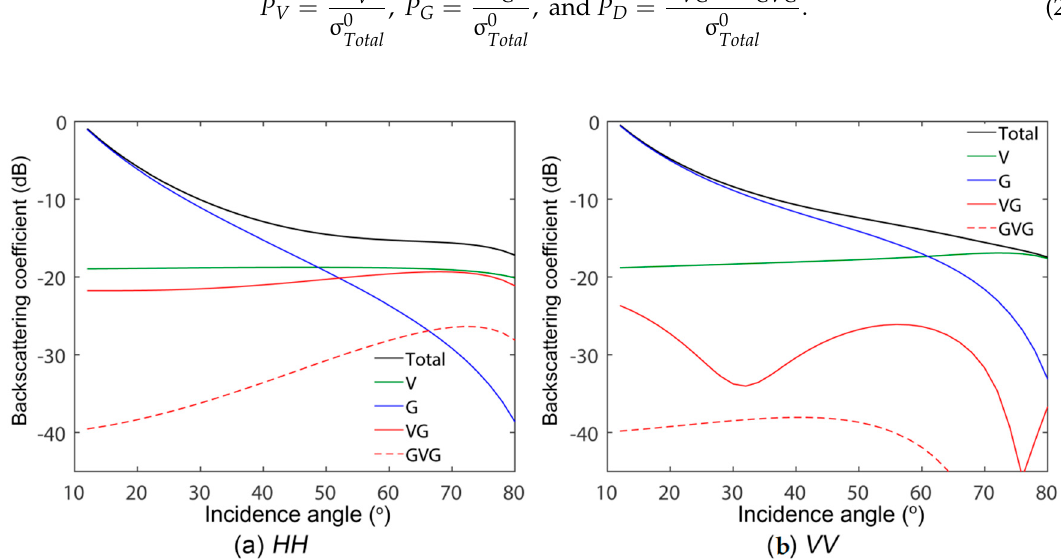
Figure 11. An example of the variations of backscattering coe ffi cients for the four di ff erent scattering mechanisms at ( a ) HH- and ( b ) VV-polarizations as a function of the incidence